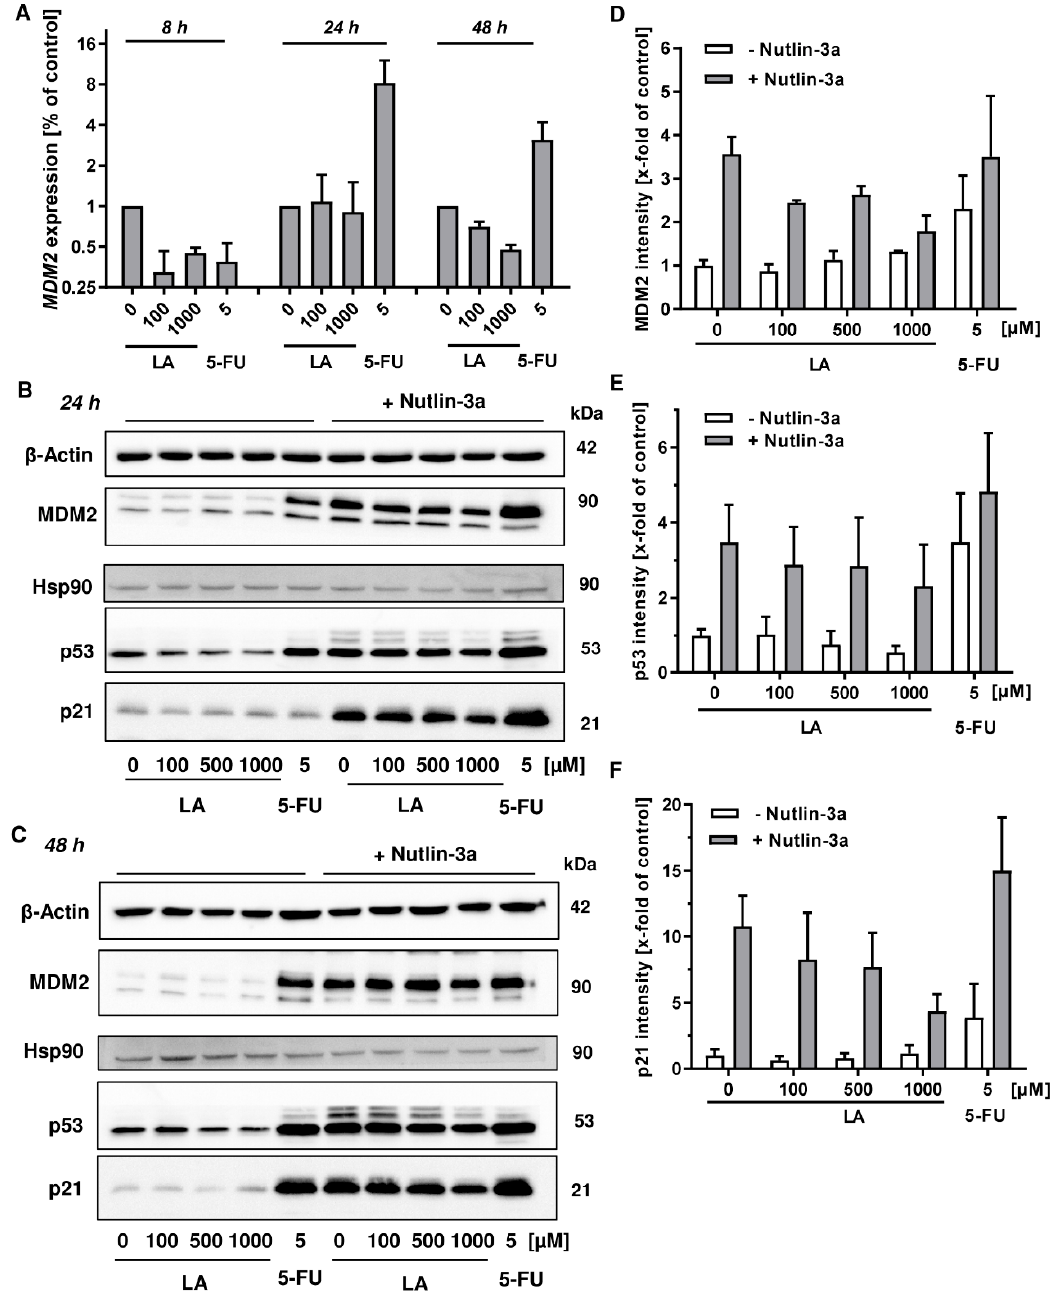
Figure 7. Role of MDM2 in LA-triggered p53-depletion in HCT116 cells. ( A ) Time course of